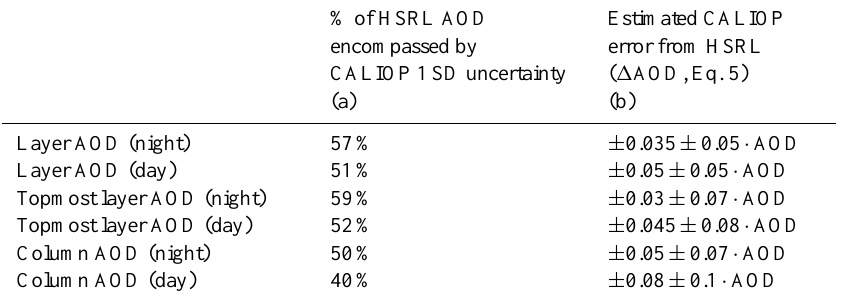
Table 3. Summary of CALIOP error estimates from HSRL. The (a) column represents the percentage of HSRL AOD that fell within 1SD of the CALIOP uncertainty estimate from the CALIOP data files. The (b) column represents the confidence envelope (Eq. 5) for CALIOP AOD based on the comparison with HSRL AOD.